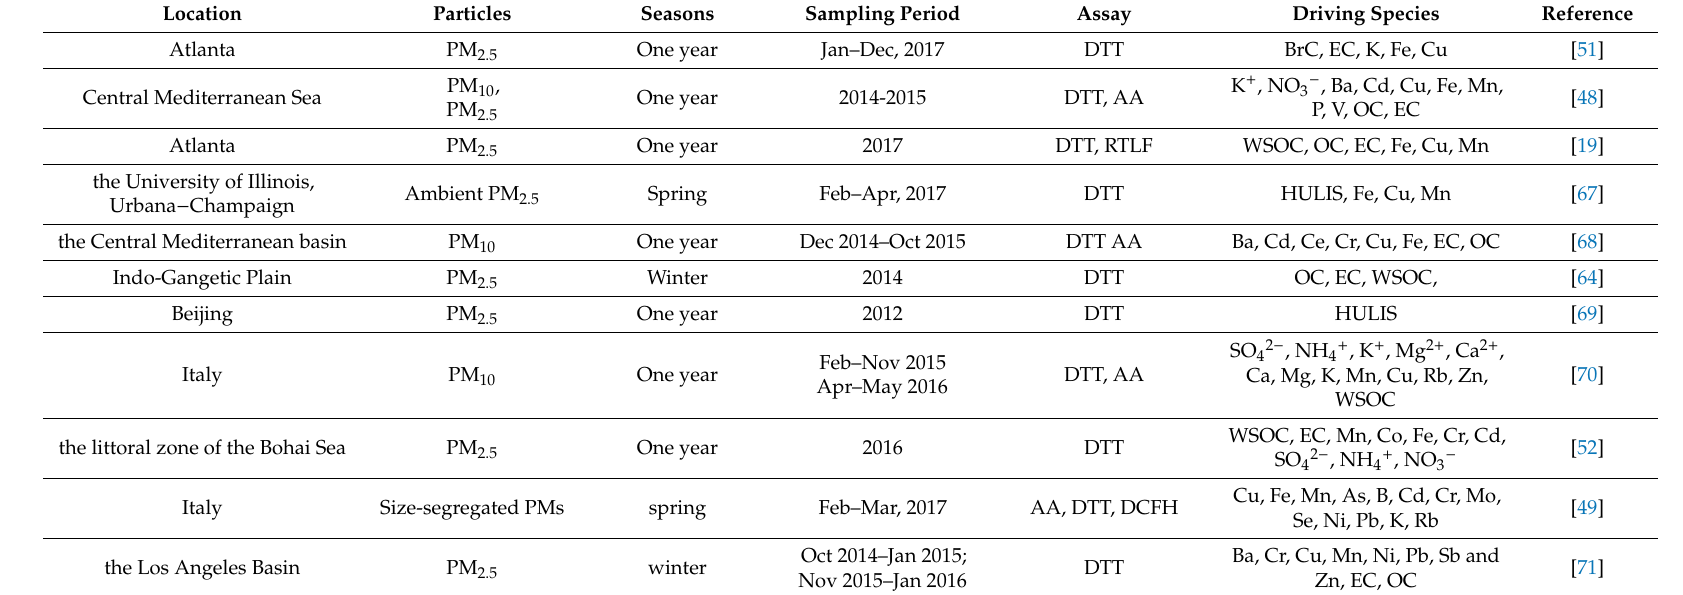
Table 2. Summary of driving species of oxidative potential (OP) mainly measured by DTT assay reported in